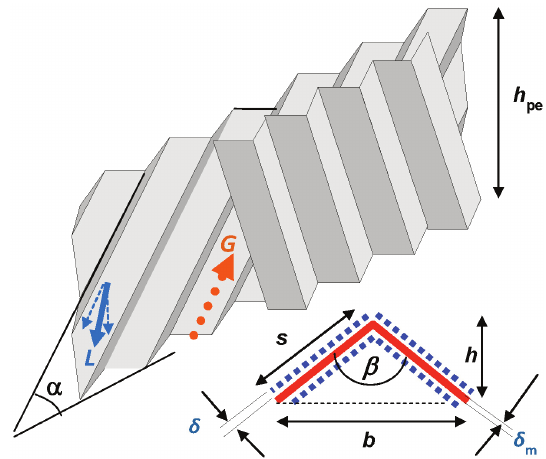
Fig. 4 – Schematic illustration of gas or vapor flow channels formed between neighboring corrugated sheets with oppositely oriented corrugations, with a sketch illustrating basic dimen- sions of a V-shaped flow channel, where α ( o ) is corrugation inclination angle, β ( o ) is apex or fold angle, b (m) is corruga- tion base width (perpendicular to gas or vapor flow direction), h (m) corrugation height, s (m) corrugation side length, δ (m) liquid film thickness, δ (m) thickness of metal used to make m corrugated sheets, and h (m) height of a packing element or pe layer, while G and L indicate direction of pressure-driven as- cending gas or vapor flow and gravity-driven descending liquid film